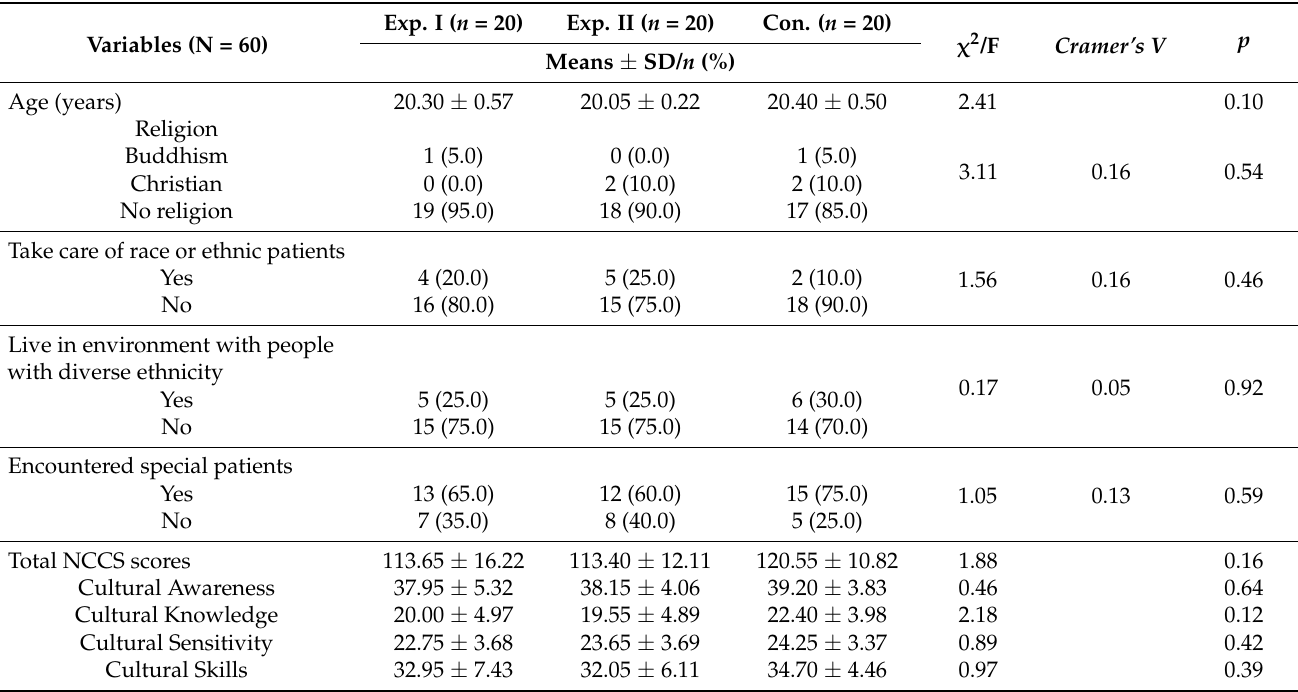
Table 2. Homogeneity test of general characteristics and NCCS scale among three groups (N = 60).